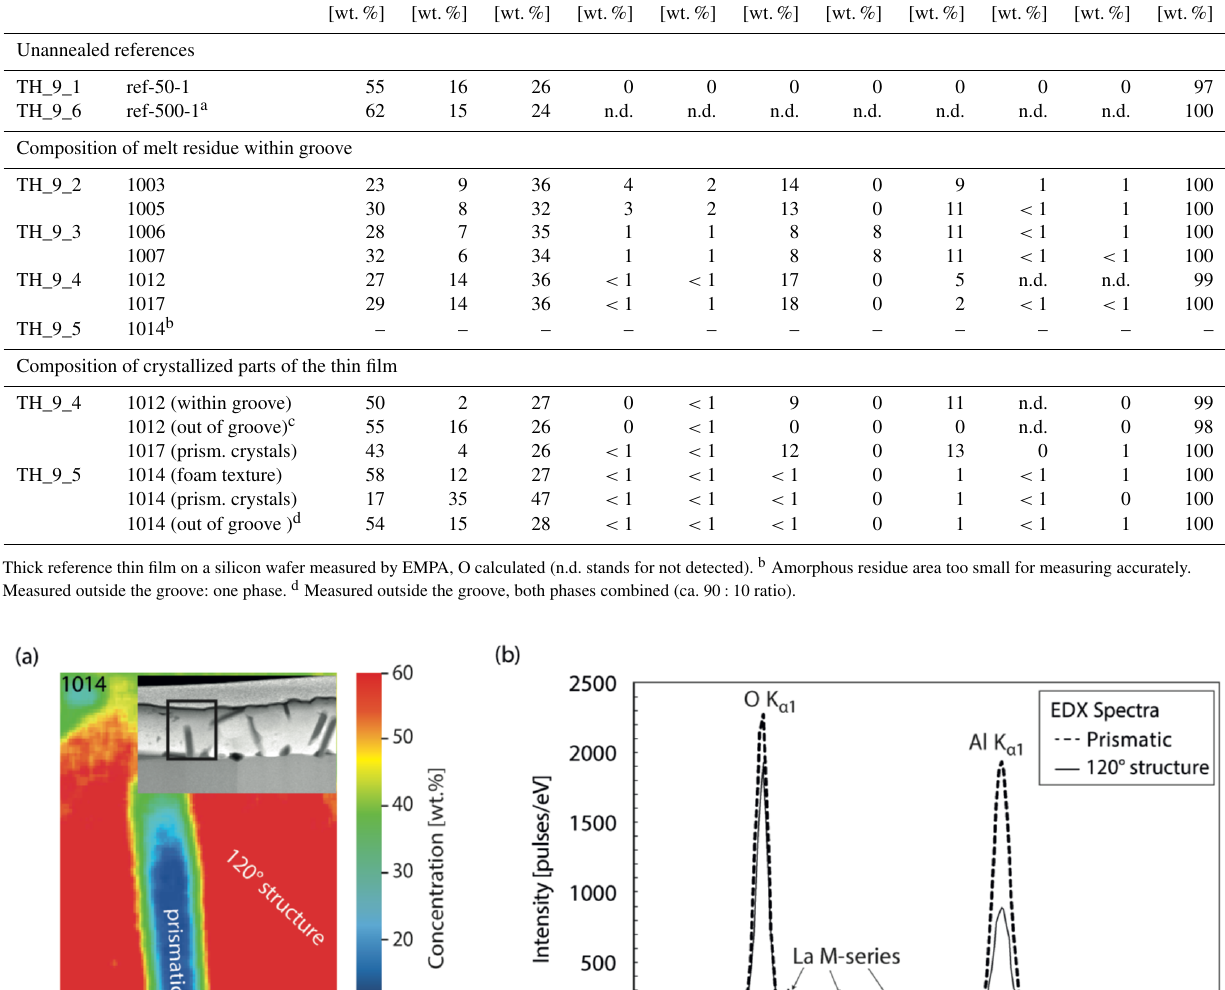
Table 2. Composition of the unannealed thin film, the amorphous residue within groove, and the crystallized parts of the thin film. Sample ID FIB lamella no.